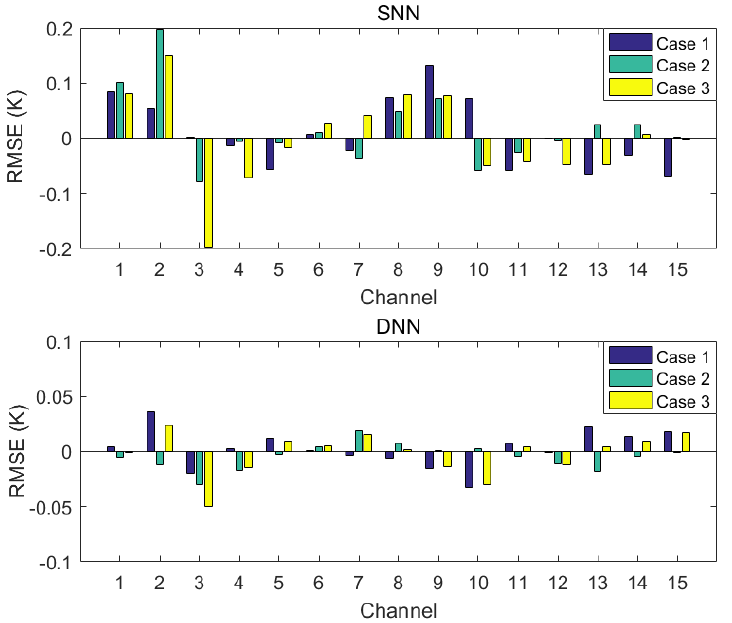
Figure 13. The stability test result of SNN and DNN in MWHTS-observation-bias correction.